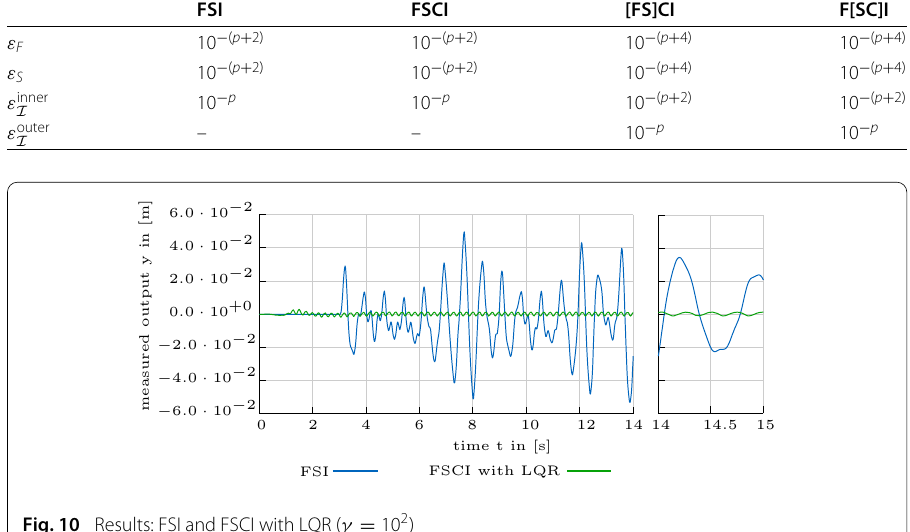
table, the proportions of values for the stopping criteria of the coupled simulations for the different variants of partitioned simulation patterns are listed. At first the overall desired numerical accuracy, which finally is to be achieved for the overall coupled simulation, was selected in this case to be p = 7, resulting in a value of ε I = 10 − 7 for the interface iterations. Afterwards the values of ε F for the fluid solver and ε S for the structural solver as well as for the inner interface iteration loop ε inner I and the outer interface iteration loop ε outer I were adopted according to the criteria described